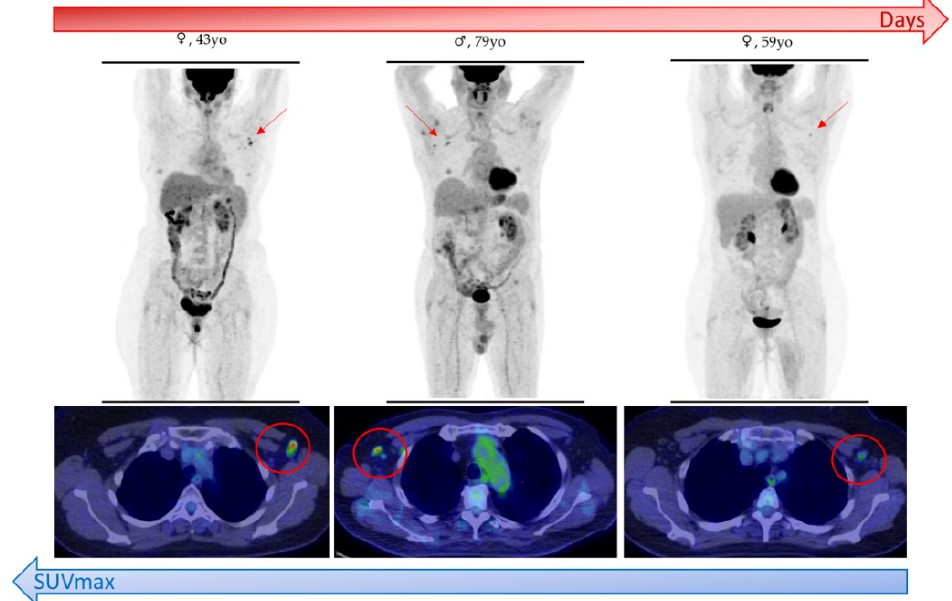
Figure 4. Schematic representation of inverse correlation between time interval from vaccination to PET/CT and maximum standardized uptake value (SUVmax) of vaccine-associated hypermetabolic lymphadenopathy (VAHL) detected in patients who underwent [ 18 F]FDG